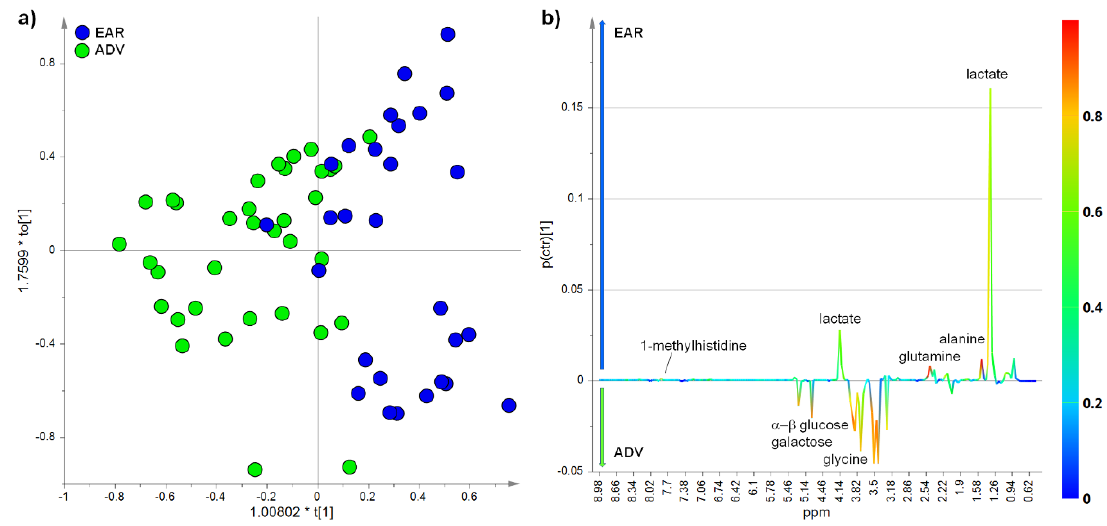
Figure 2. Serum metabolic profile discriminates between advanced and early HCC patients. ( a ) Orthogonal partial least squares discriminant analysis (OPLS-DA) score plot (R 2 X = 0.75, R 2 Y = 0.58, Q 2 = 0.38 p[CV-ANOVA] = 9.00484 × 10 − 5 (Cohen’s coefficient (K) equal to 0.968, Table S 1) and ( b ) the corresponding S-line plot for the model displaying the discriminant metabolites and the related predictive loadings (variables in the proton Nuclear Magnetic Resonance ( 1 H-NMR) spectra. Variables are colored according to the correlation scaled loading (p(corr)). The arrows indicate the metabolite content increase for the advanced (ADV) and early (EAR) group. Table 2. Quantitative comparison of serum metabolites from ADV and EAR HCC patients.